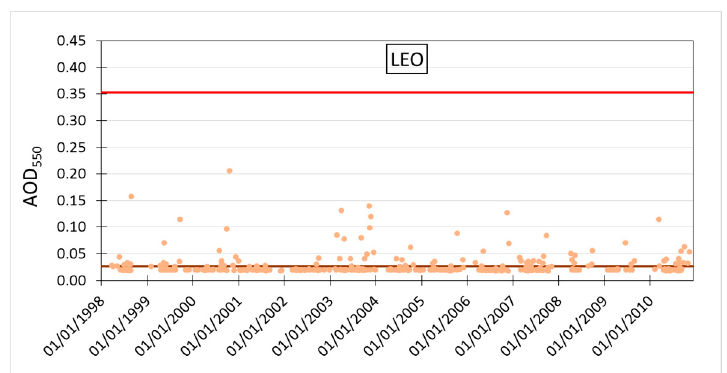
Figure 4. Area average (1° × 1°) time series (1998–2010 period) aerosol optical depth at 550 nm (AOD 550 ) for SAC and LEO sites. The mean values are: AOD* 550 , SW,SAC = 0.0262 ( σ P = 0.161) for SAC (top figure) and AOD* 550,SW,LEO = 0.0266 ( σ P = 0.161) for LEO (bottom figure). The red line corresponds to the limiting value given by Formula (1). Note: in the top figure, the red arrows indicate the Lascar volcano eruption days: 20 July 2000, 26 October 2002, 4 May 2005 and 18 April 2006. Source: SeaWiFS instrument on SeaStar/NASA satellite Deep Blue Level 3 long-term aerosol data at http://disc.sci.gsfc.nasa.gov/giovanni/.